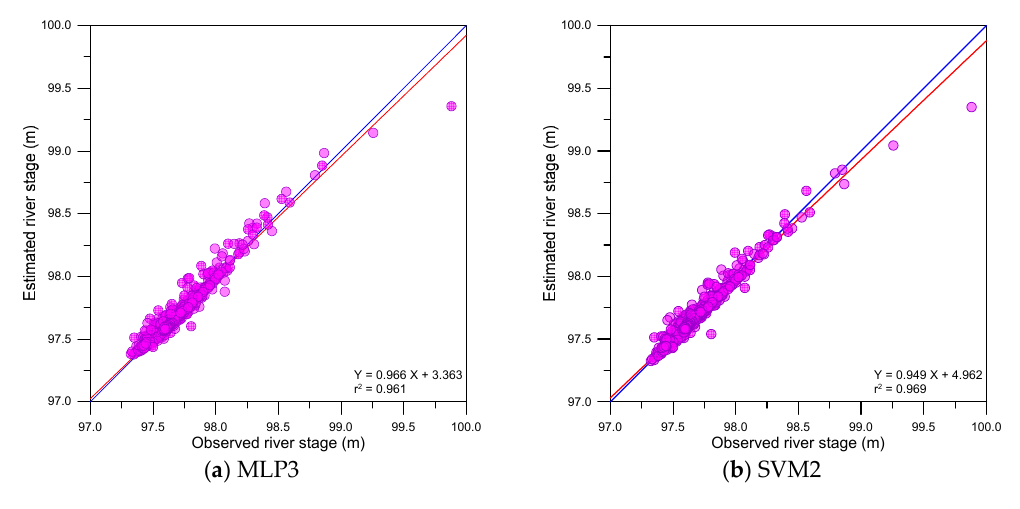
Figure 9. Scatter plots for the MLP and SVM models.